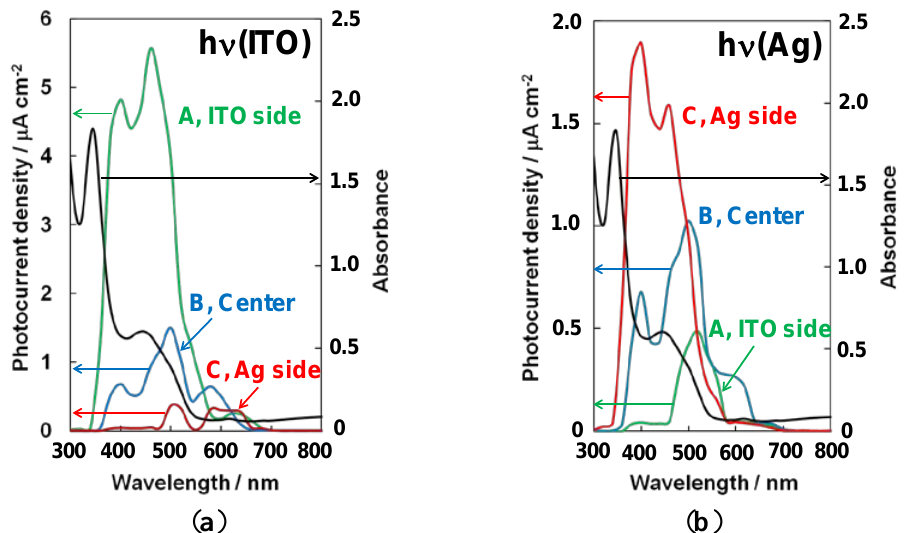
) under irradiation Figure 15. Action spectra of the short-circuit photocurrent density (J sc onto the ITO electrode ( a ) (hν(ITO)) and onto the Ag electrode ( b ) (hν(Ag)). Curves A, B, and C are for cells ( a ); ( b ); and ( c ) in Figure 14, respectively. The black curve shows the film (150 nm). The monochromatic light intensity irradiated absorption spectrum of the C 60 to the electrodes is around 3 mWcm −2